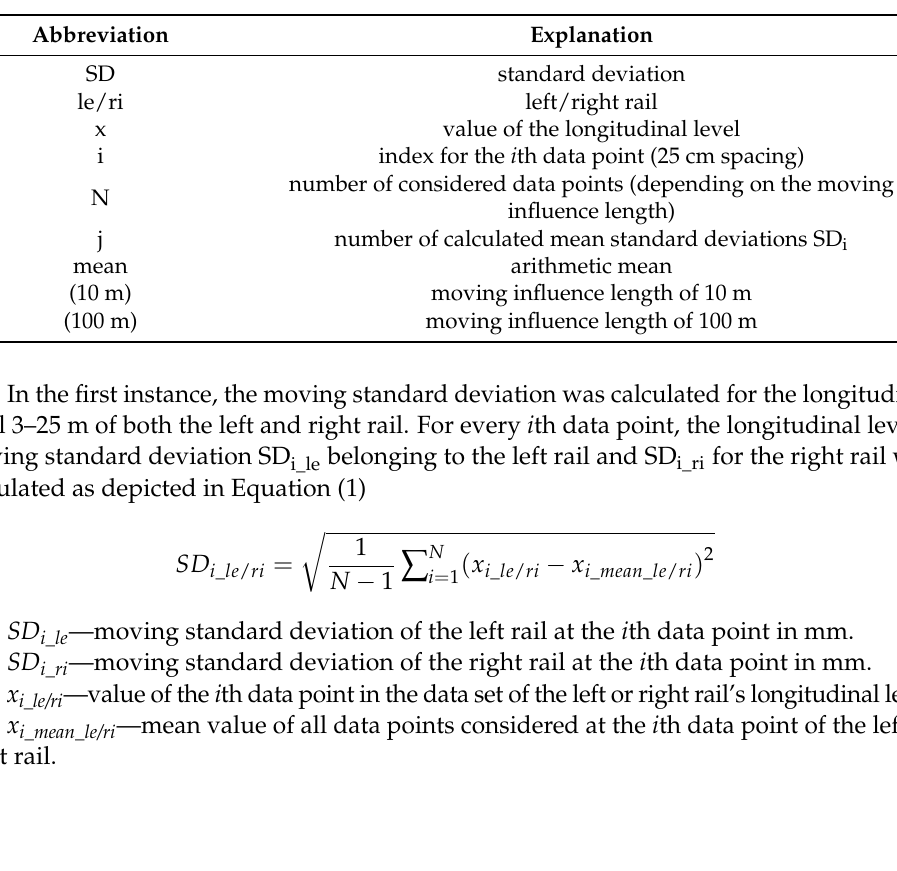
Table 3. Meaning of